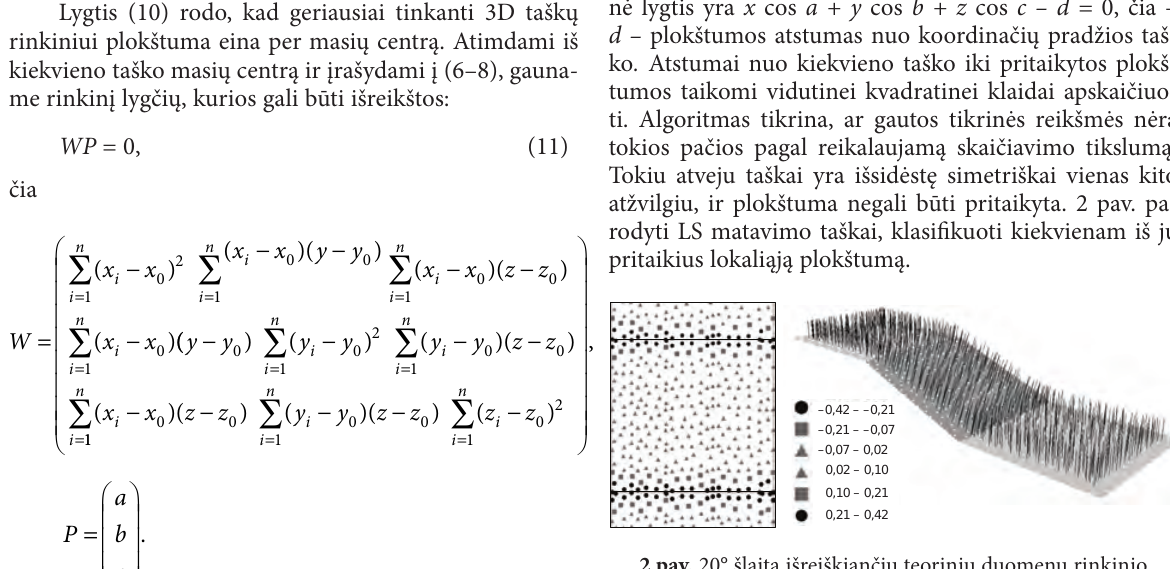
pritaikytų plokštumų reikšmes (m) Fig. 2. Data on a 20° slope classified by the distances of the fitted plane (distance,